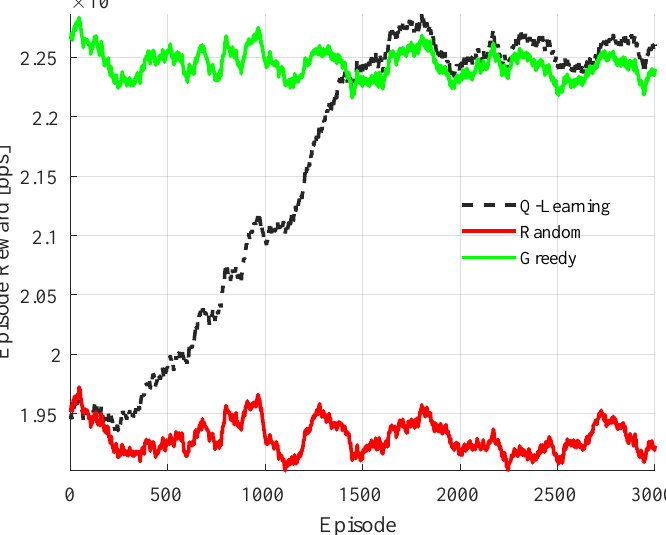
Figure 4. Averaged reward per episode during MAQL training for joint channel and power selection with s th = 2